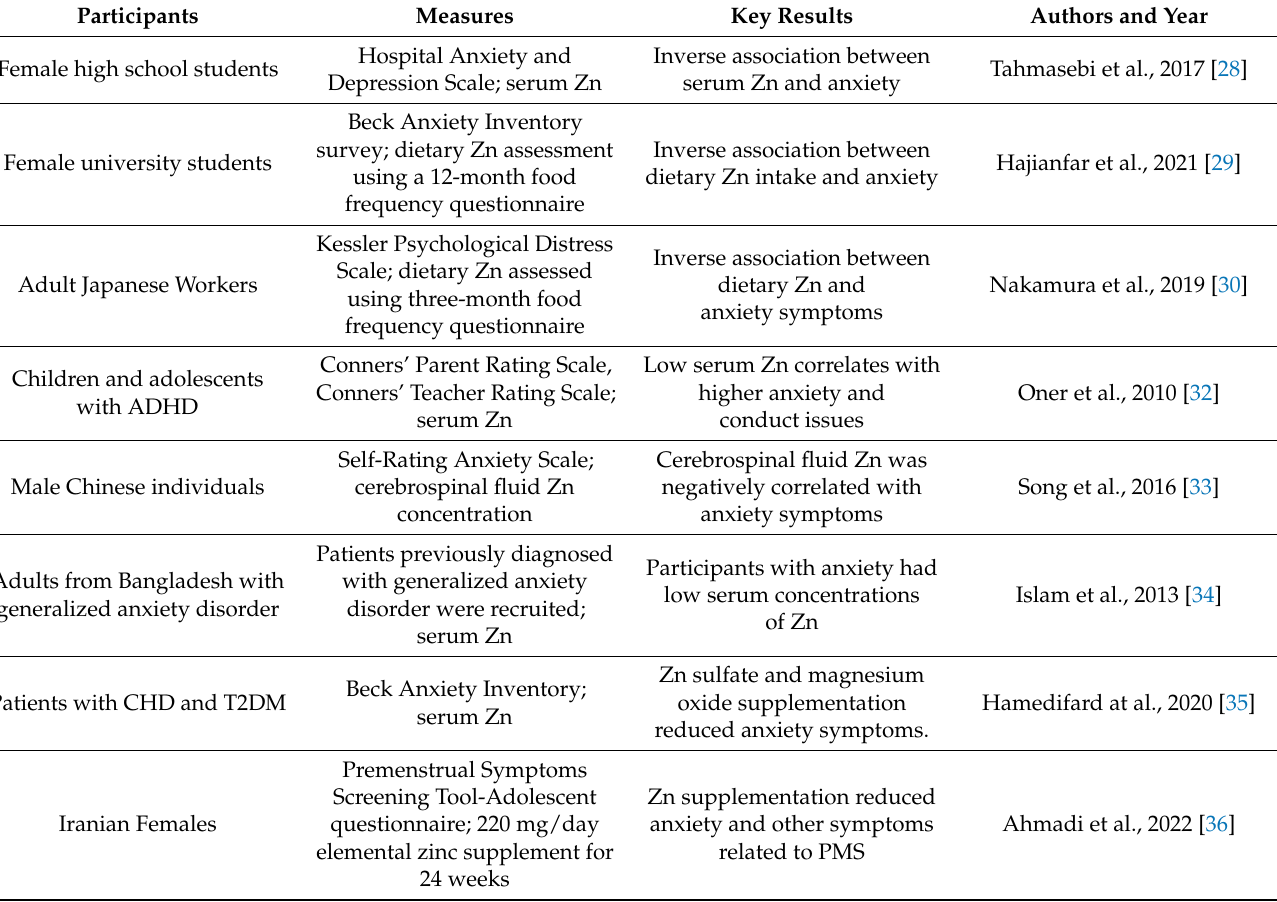
Table 1. Summary of clinical evidence for the relationship between zinc (Zn) and